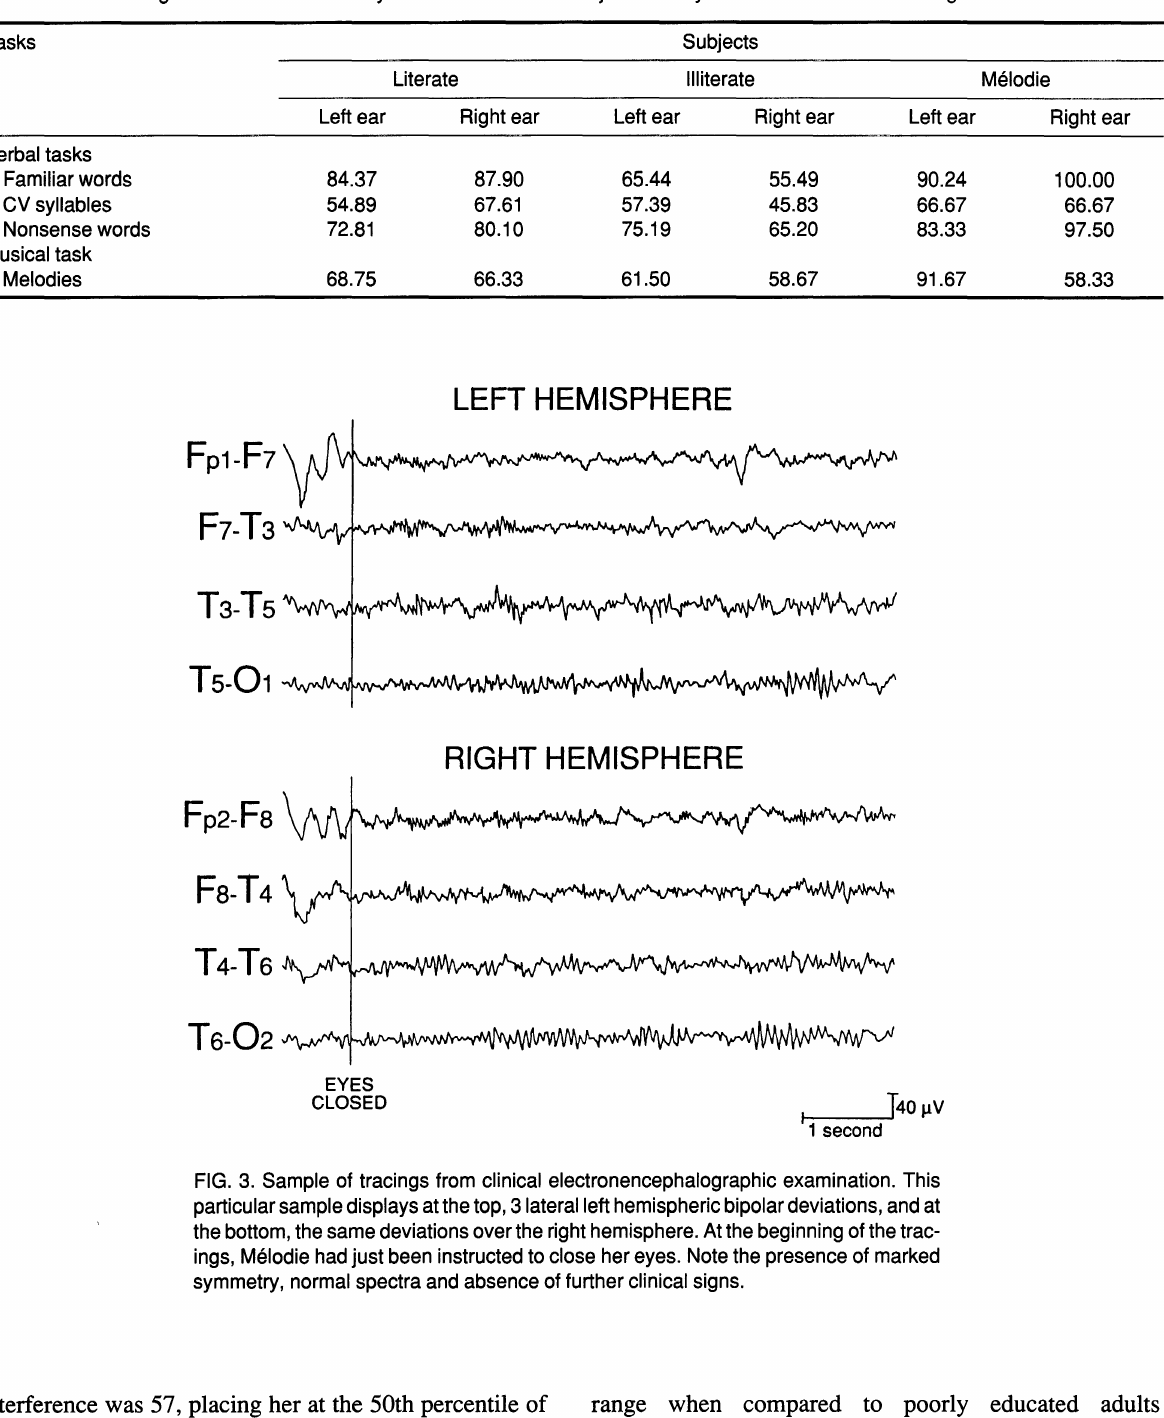
TABLE III. Percentage of success obtained by literate and illiterate subjects and by Melodie on dichotic listening tasks Tasks